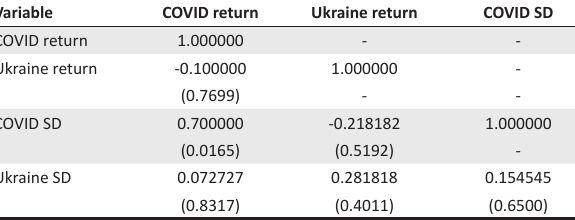
TABLE 7: Spearman’s rank